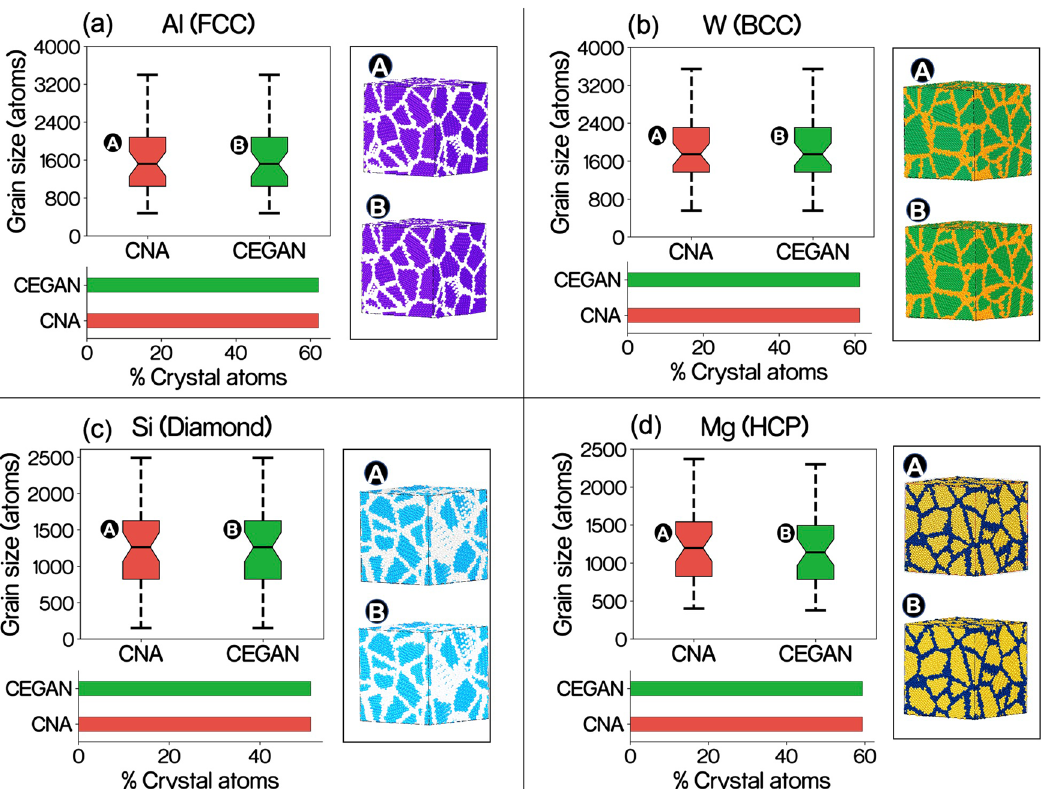
Fig. 5 Characterization of grain boundary and grain size distribution in polycrystalline materials. Grain size distribution of polycrystals of a Aluminum (FCC), b Tungsten (BCC), c Silicon (Diamond), and d Magnesium (HCP) computed using CEGANN + DBSCAN clustering and CNA (Common neighbor analysis) + DBSCAN